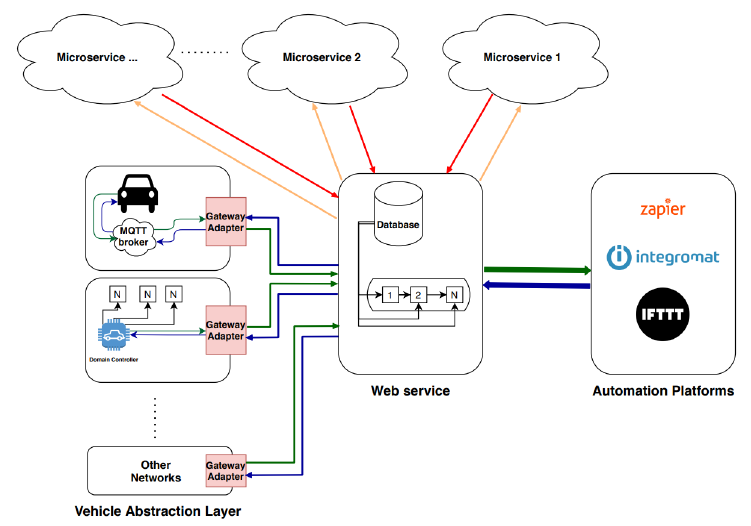
Figure 10. Digital gate system